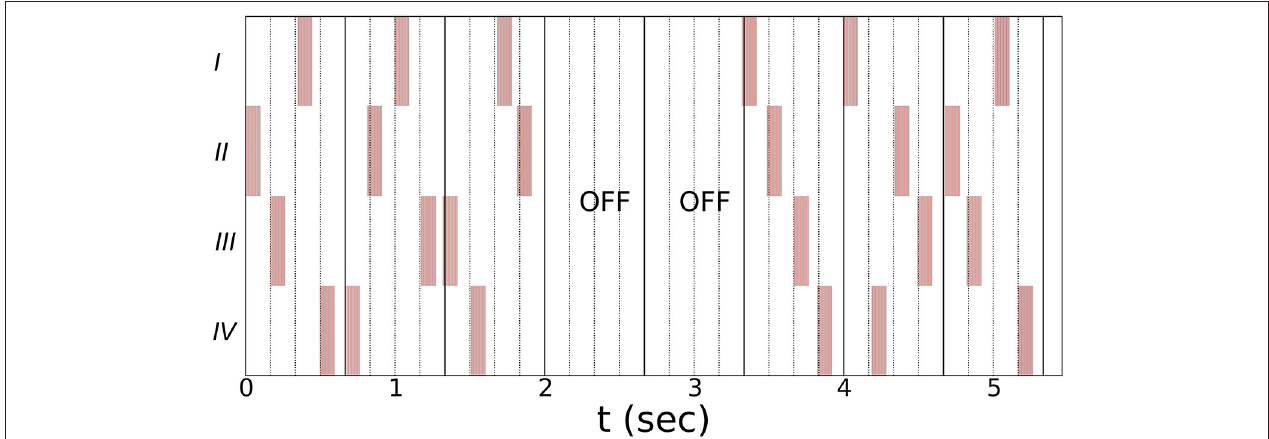
FIGURE 1 | Schematic illustration of the vCR stimulation using a three cycles ON: two cycles OFF pattern (17). Single vibratory bursts (highlighted by red bars) are delivered at periodic times subjected to a jitter that is uniformly distributed within the range of ± 23.5% the inter-stimulus intervals. A vCR sequence comprises four subsequent vibratory bursts, delivered (on average) within one vCR cycle. Within one vCR sequence each fingertip (two through five) is activated exactly once. The CR frequency f CR , i.e., the rate at which the CR sequences are delivered, is 1.5Hz. Hence, the length of a CR cycle is 667ms. Bilateral noisy vCR is administered in a mirrored manner to both hands, coincidently activating right and left fingers (two through five). Schematic shows the vCR pattern coincidently delivered to left and